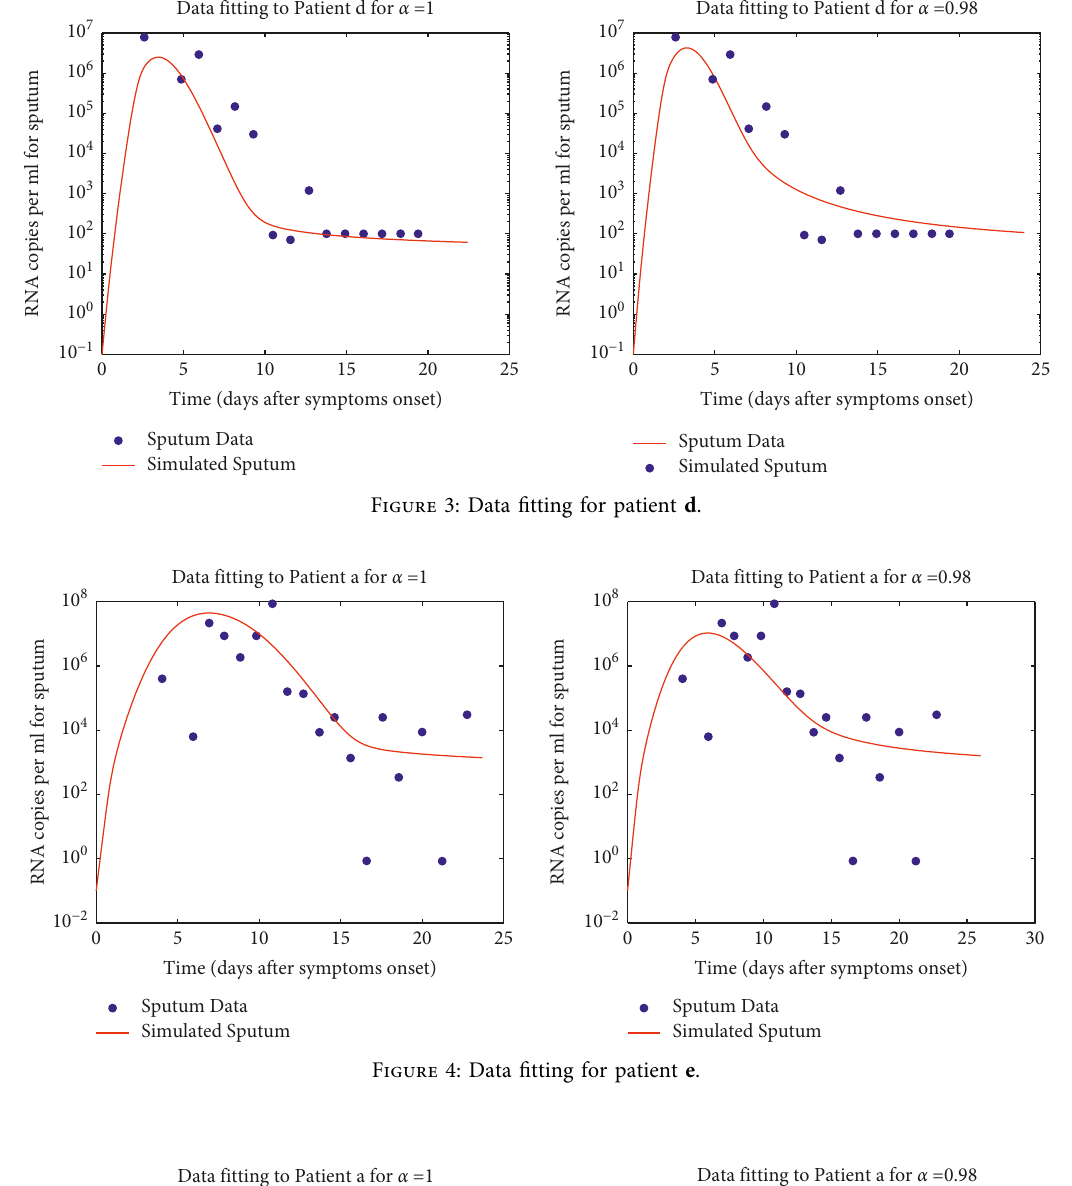
Data fitting to Patient a for α =1 Data fitting to Patient a for α =0.98